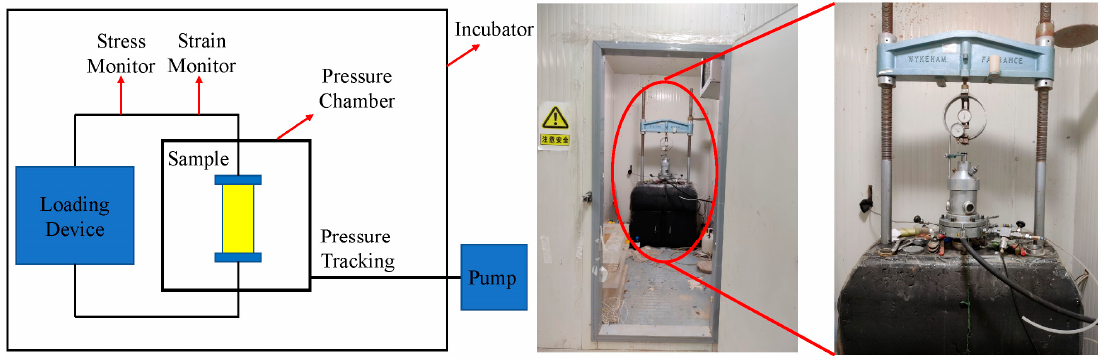
Figure 4. Schematic diagram and photo of the high-pressure and low-temperature triaxial test ap- paratus.